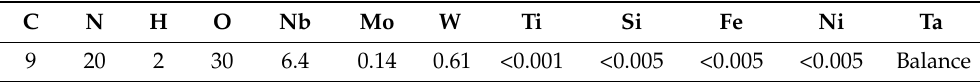
Table 1. Chemical composition of high purity Ta (wt.